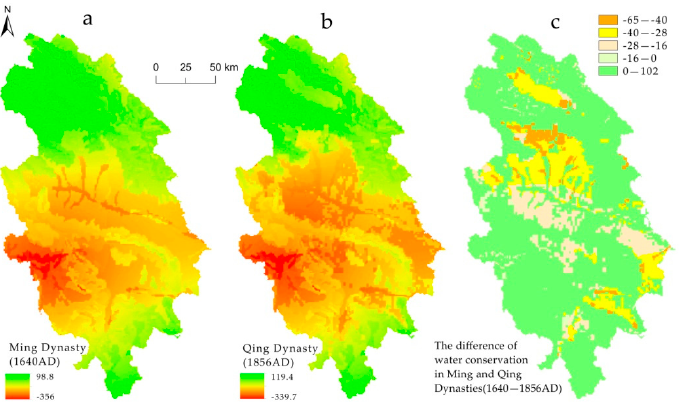
Figure 5. The water conservation in Ming and Qing Dynasty of the Hehuang